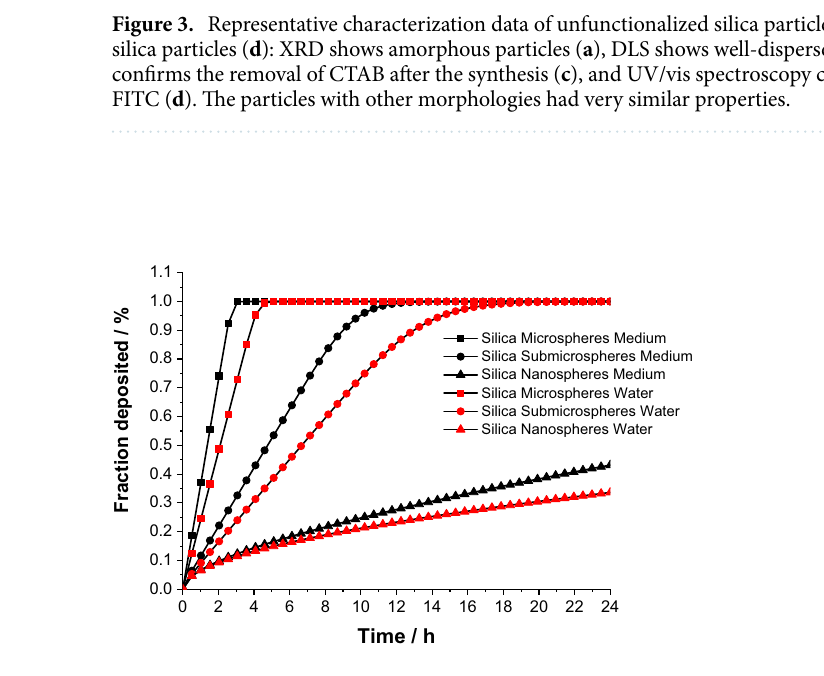
Figure 4. Precipitation and diffusion of spherical silica particles according to the ISDD model in water and in cell culture medium (DMEM supplemented with 10%